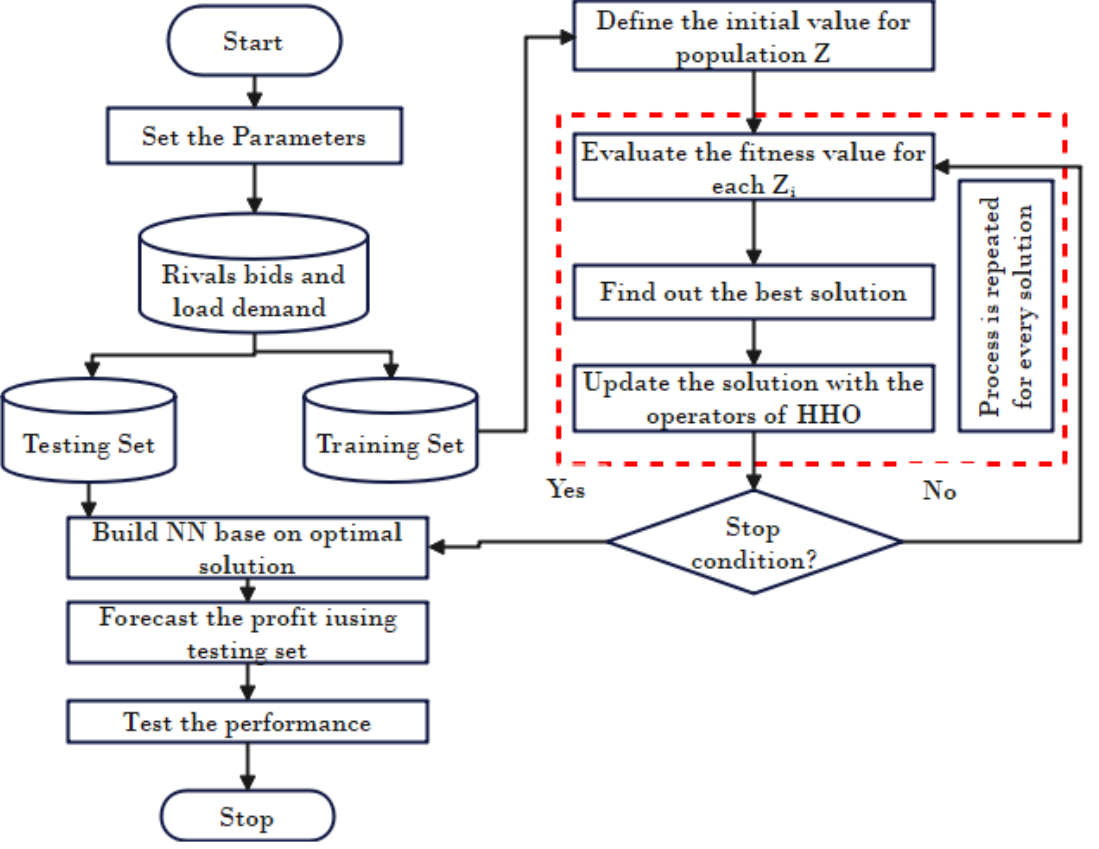
Figure 11. The proposed HHO-NN